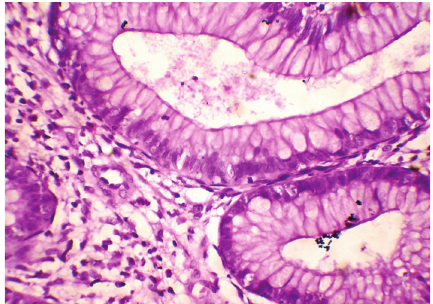
Figure 9: Biopsy showing adenomatous changes with chronic